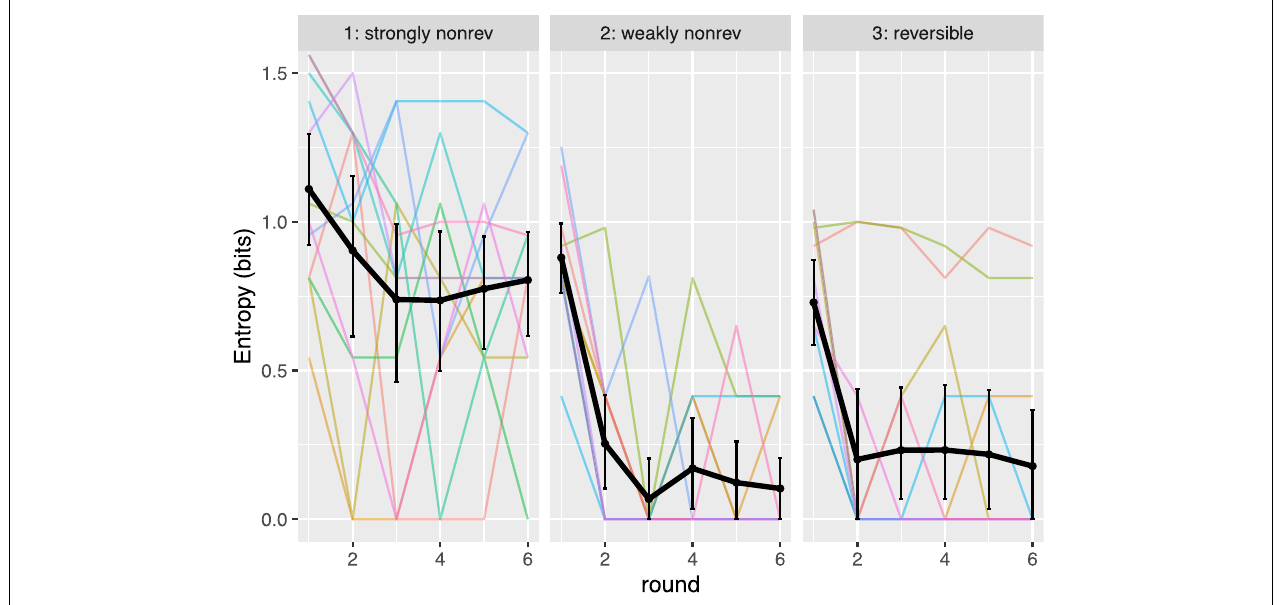
FIGURE 6 | Entropy (bits) by round, for each of the three event types. Black lines represent means, and colored lines represent dyads. Error bars represent bootstrapped 95% confidence intervals. We can observe a drop in entropy over time, on average, supporting the hypothesis that over time, participants become more consistent in their word order use. On average, entropy stays higher for strongly non-reversible events.